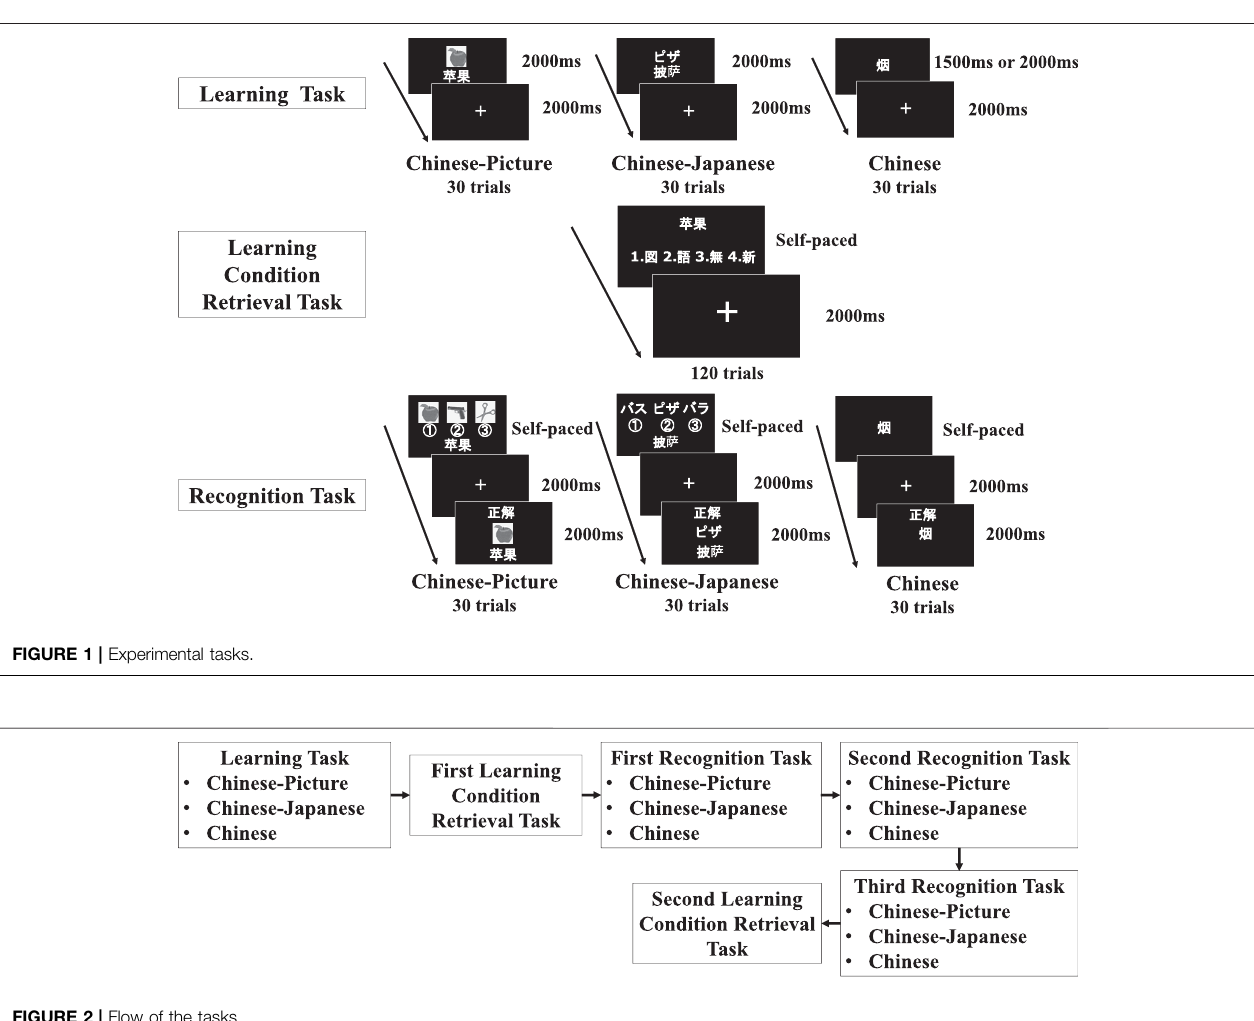
FIGURE 2 | Flow of the